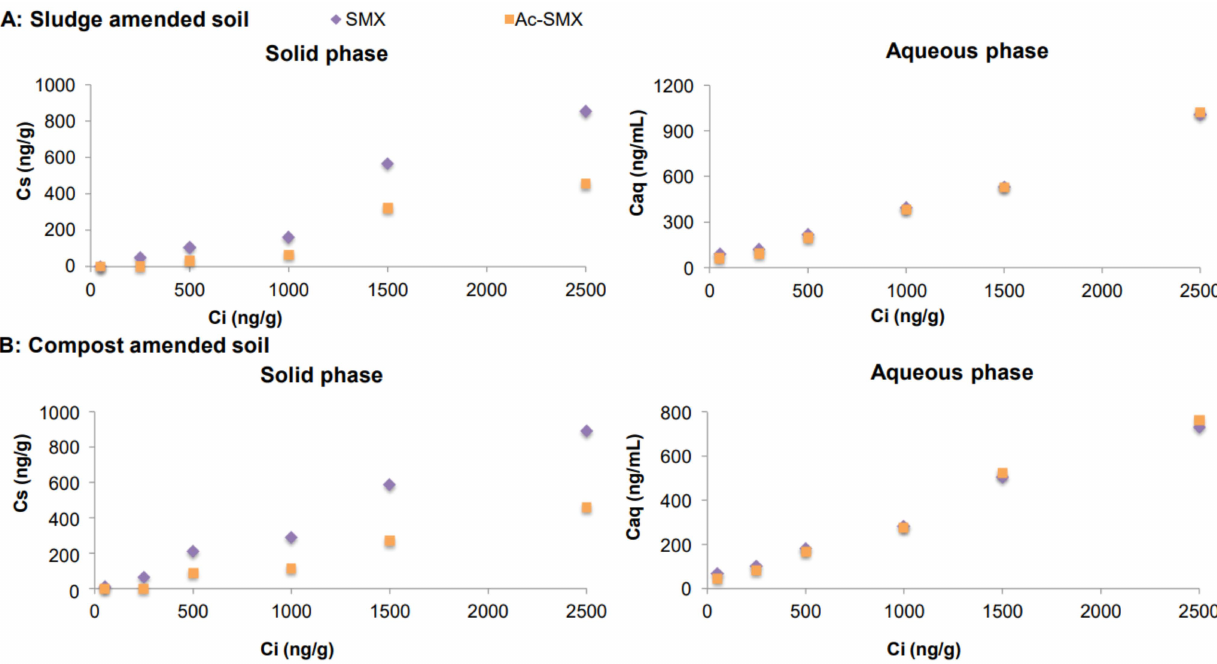
Figure 4. Concentrations of SMX and its metabolite in soil samples amended with spiked sewage sludge ( A ) and compost ( B